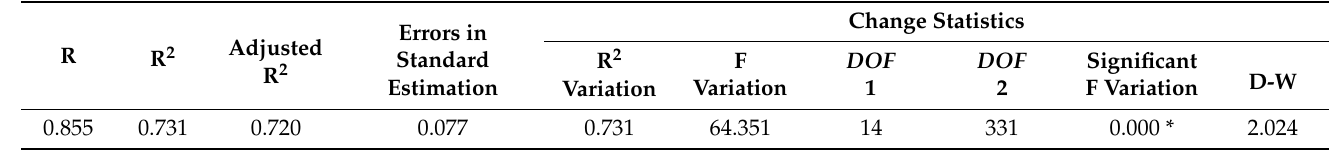
Table 7. Mixed model summary.